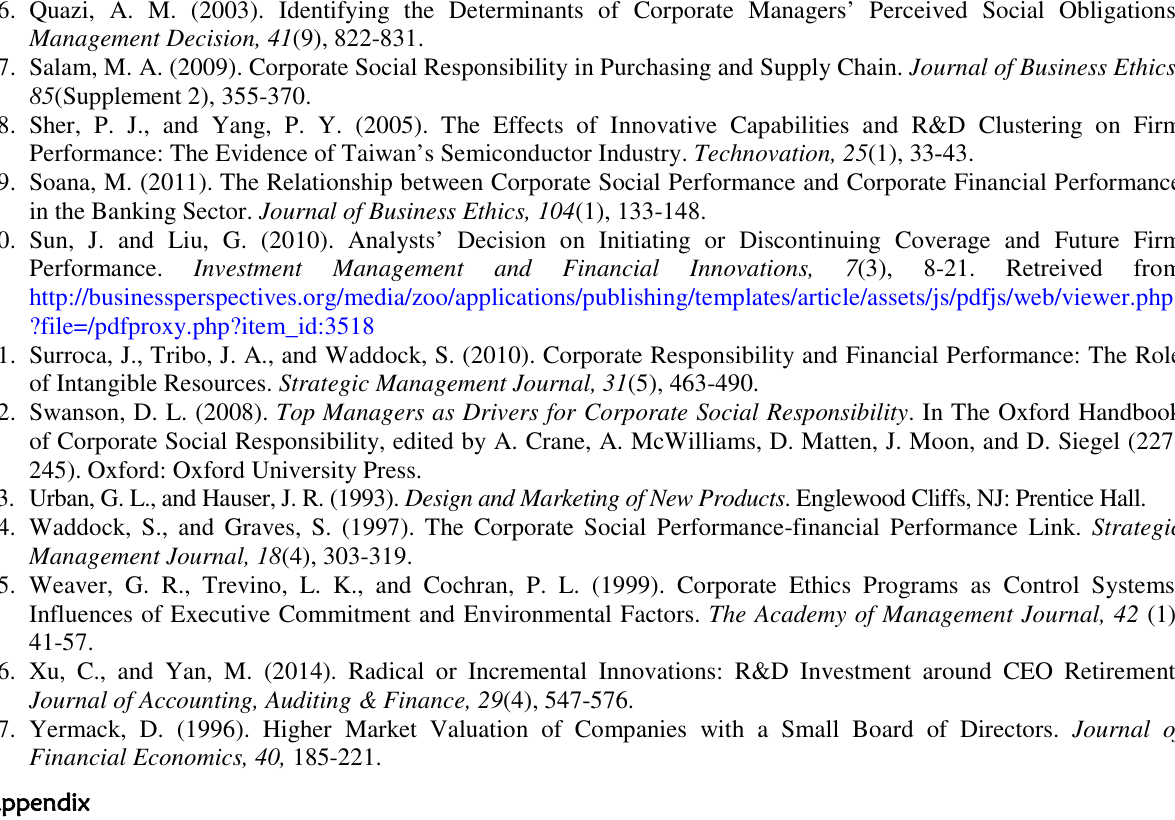
Table 1. Distribution of CSR-awarded firms and sample selection procedure Panel A: The distribution of CSR-awarded firms